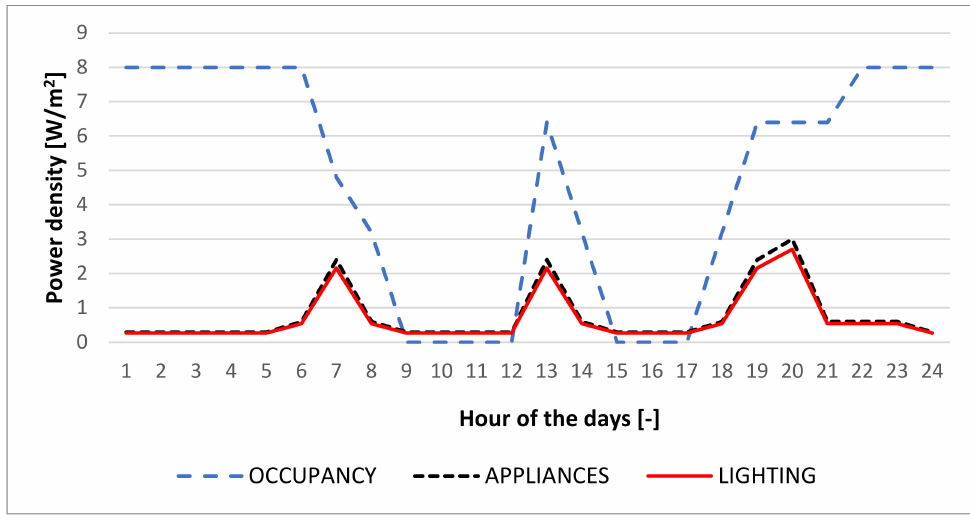
Figure 4. Internal heat load density profile of the residential building during a